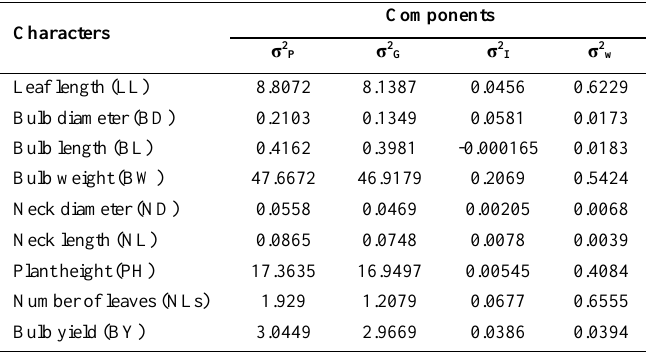
Table 1 . Values of phenotypic (σ 2 P ), genotypic (σ 2 G ), interaction (σ 2 I ) and within error (σ 2 w ) components of variation for nine characters in onion